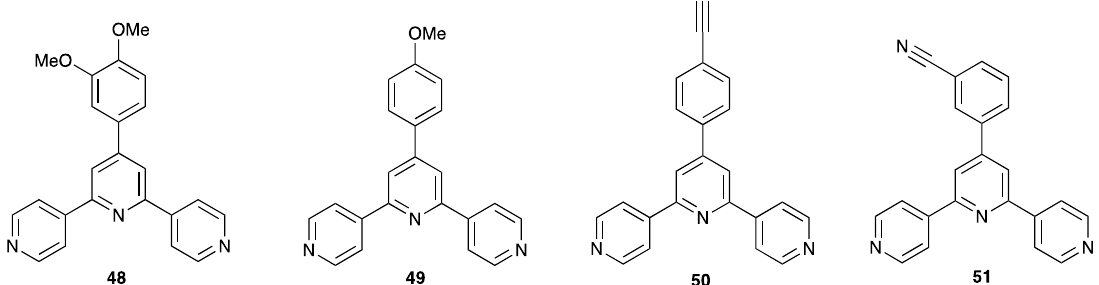
Scheme 12. Structures of some ligands with non ‐ coordinating 4’ ‐ functionalities that form coordination assemblies with